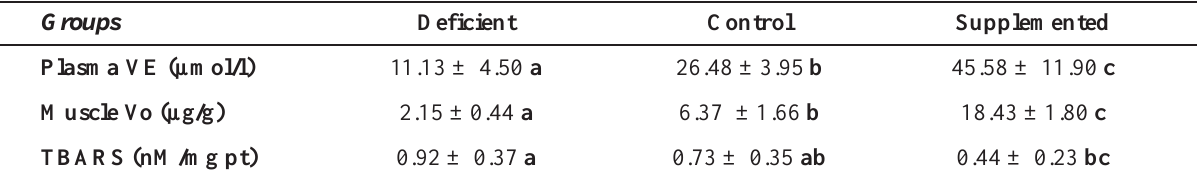
TABLE 2 - Lipid peroxidation and vitamin E levels in rats submitted to ischemia and reperfusion of skeletal muscle.